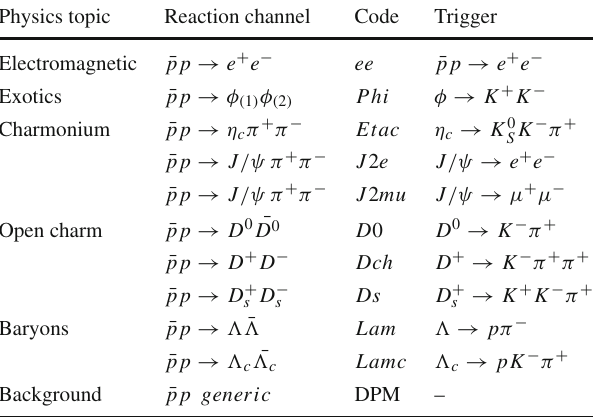
Table 1 List of ten physics channels for the Software Trigger study together with the corresponding codes used in this document and the trigger signatures